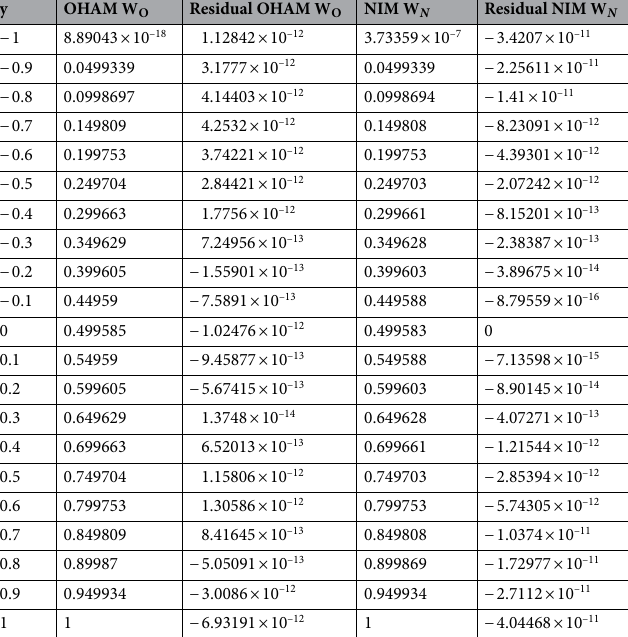
Table 1. For A = 0.002, B = 0.1, M = 0.00015 and (cid:31) =